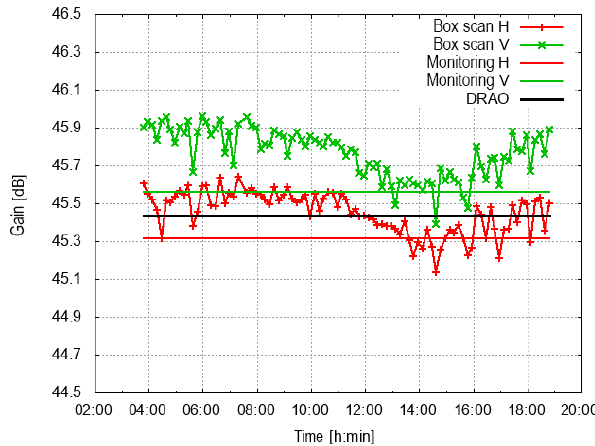
Figure 9. S 2 variability during 3 June 2018 (UTC) compared to the S 2 and Z DR from operational monitoring. Operational data are updated once a day. No update of Z DR is possible if there has not been sufficient precipitation over the radar site on the previous day. In that case we keep the Z DR from the last precipitation event (here